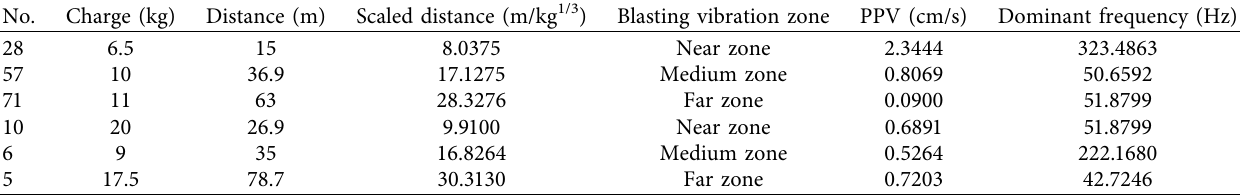
Table 3: Typical blasting vibration data in the near, medium, and far zones.